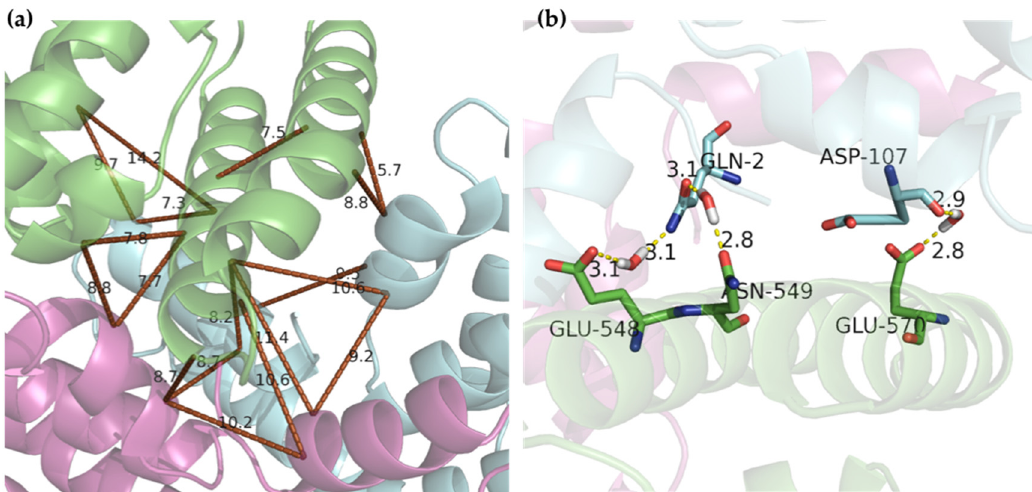
Figure 6. Hydrophilic cavity ( a ) in areas A and B and a possible example in area A ( b ). Some distances were measured and are shown in brown lines. The example is in the triangle with side lengths of 11.4, 9.2 and 10.6 Å. The gray atoms are hydrogen atoms in the left panel. The green chain is BSA. The pink and blue chains are α and β subunits of C-phycocyanin, respectively.